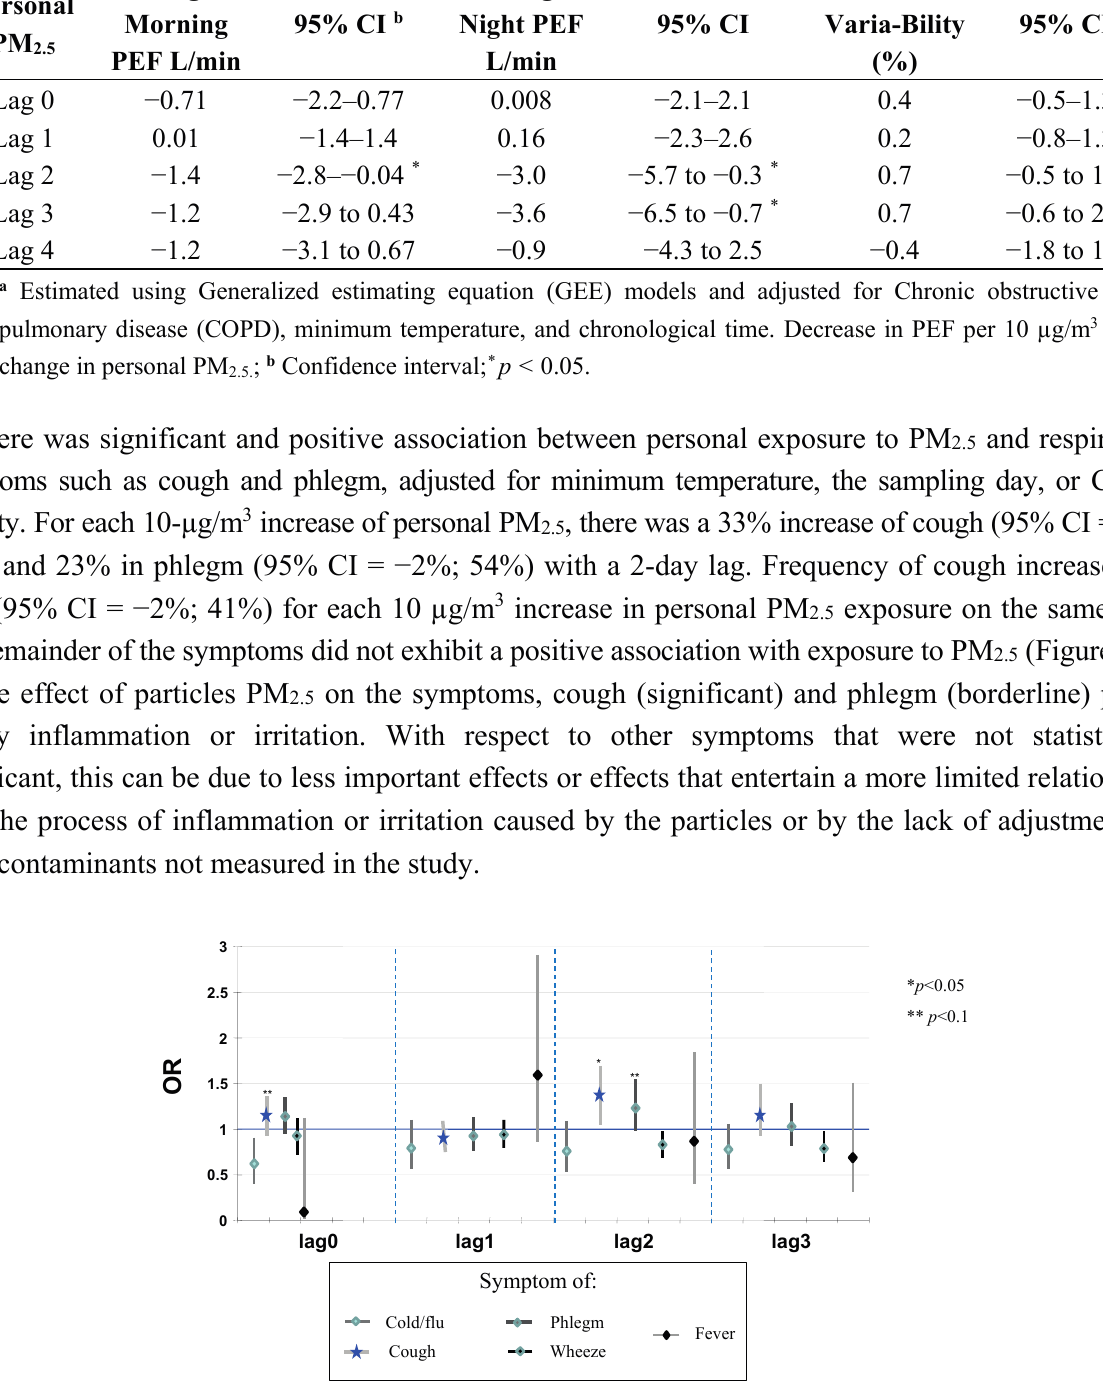
Figure 3. Effect of personal of exposure to particulate matter with an aerodynamic diameter less than 2.5 µm (PM 2.5 ) on respiratory symptoms, Mexico